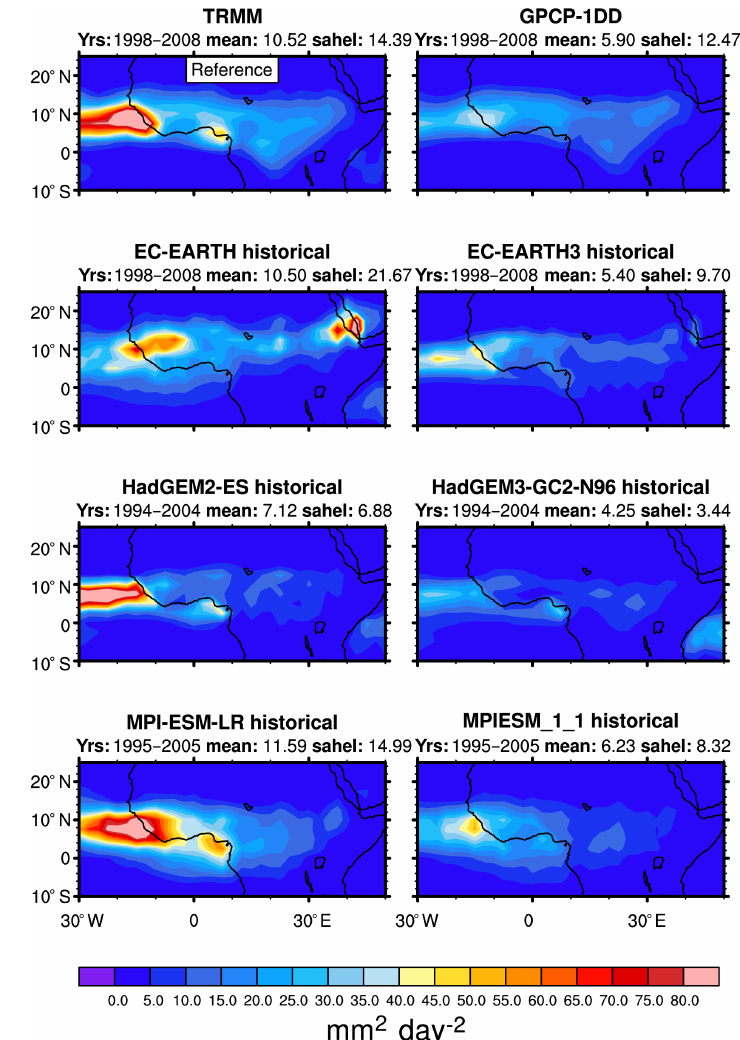
Figure 11. JJAS average 3–10-day band-pass-filtered precipitation variance (mm 2 day − 2 ) calculated from 11 years of daily precipitation fields as indicated above the panels. The top two panels show observations from TRMM (left panels) and GPCP-1DD (right panels). Shown are the coupled simulations from (left panels) the CMIP5 and (right panels) the EMBRACE-updated models. All data have been interpolated onto a common 2.5 ◦ × 2.5 ◦ grid. The band-pass-filtered precipitation variances averaged over the whole domain (“mean”) and over the rectangular region 10 ◦ W–10 ◦ E, 10–20 ◦ N (“sahel”) are given above the individual